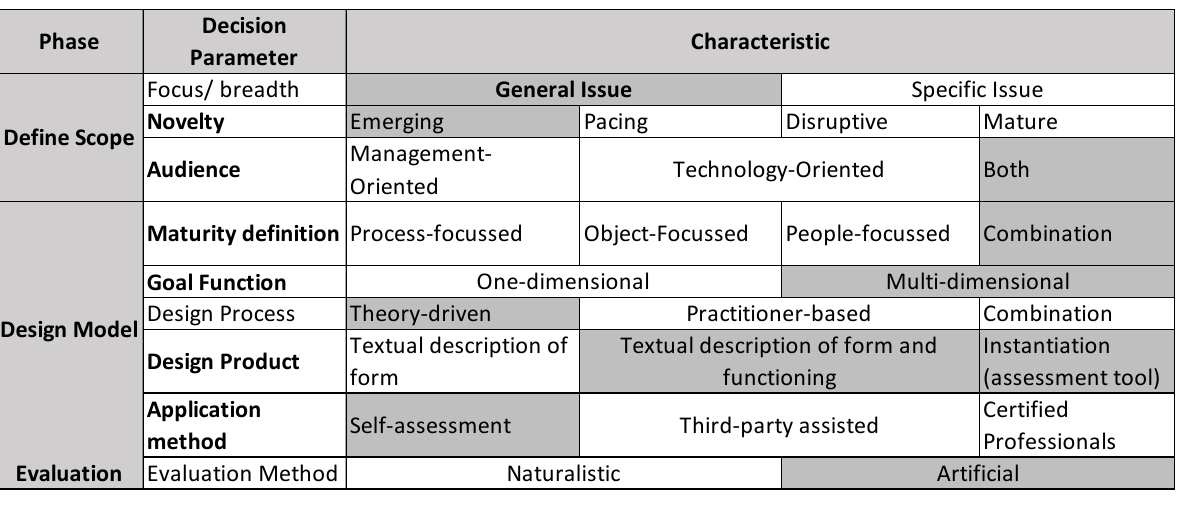
Figure 7. Construction of DX-SAMM Maturity Development.